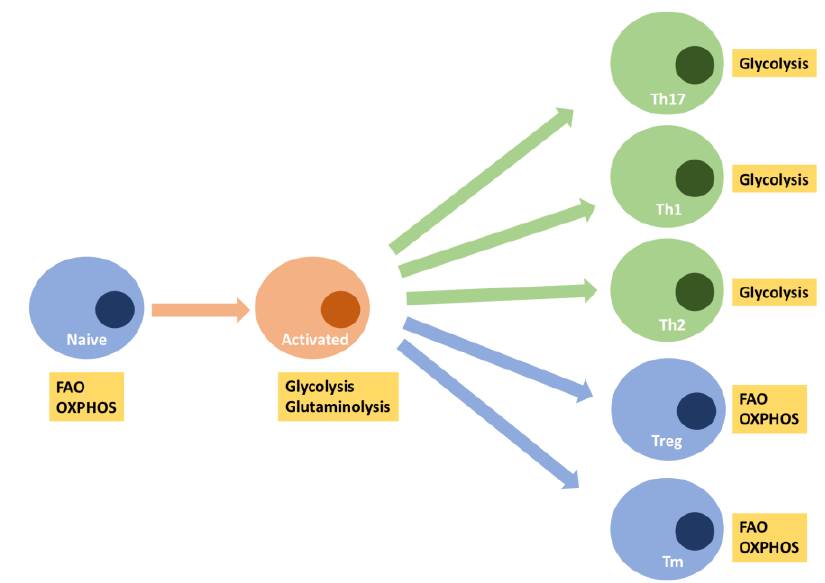
Figure 3. T-cell activation and differentiation involved metabolic reprogramming. At rest, naïve T-cells primarily use OXPHOS to derive their energy. Following activation, T-cells switch to Warburg metabolism and glutaminolysis to support their proliferative needs. Differentiation into T-helper subsets can involve either the maintenance of the Warburg phenotype (i.e., Th17, Th1, Th2), or the reversion to OXPHOS with FAO (i.e., Treg, Tm) as an important fuel. FAO = mitochondrial fatty acid oxidation, OXPHOS = oxidative phosphorylation, Th17 = T-helper cell 17, Th1 = T-helper cell 1, Th2 = T-helper cell 2, Treg = regulatory T-cells, Tm = memory T-cells.